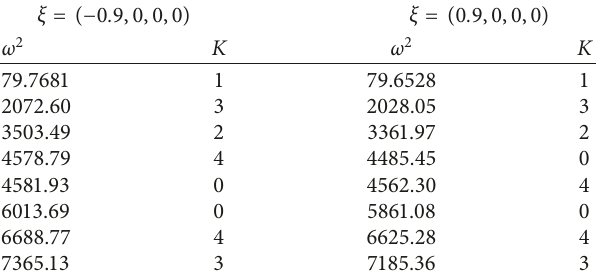
Table 2: The eigenmodes evaluated at two different points in Γ (solution computed with p � 4 and L � 3 (165 collocation points)).